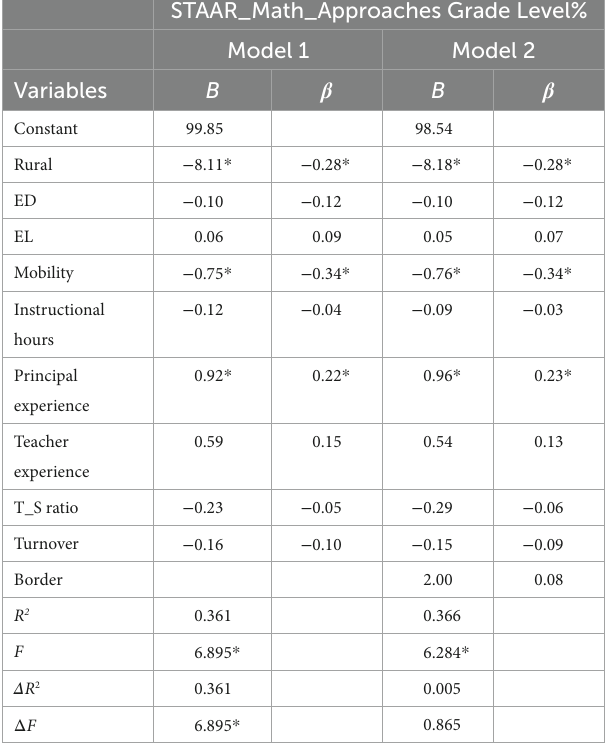
TABLE 5 Hierarchical multiple regression predicting student math achievement from demographic characteristics and border condition.